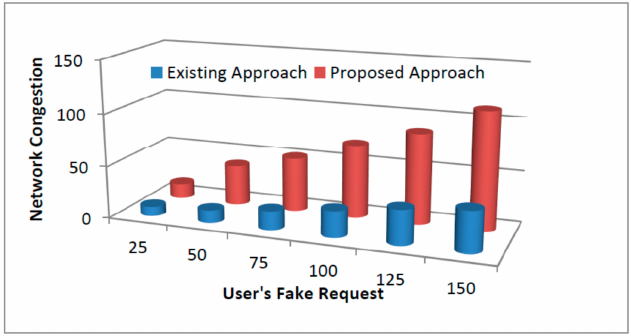
Figure 8. The users’ fake requests corresponding to network